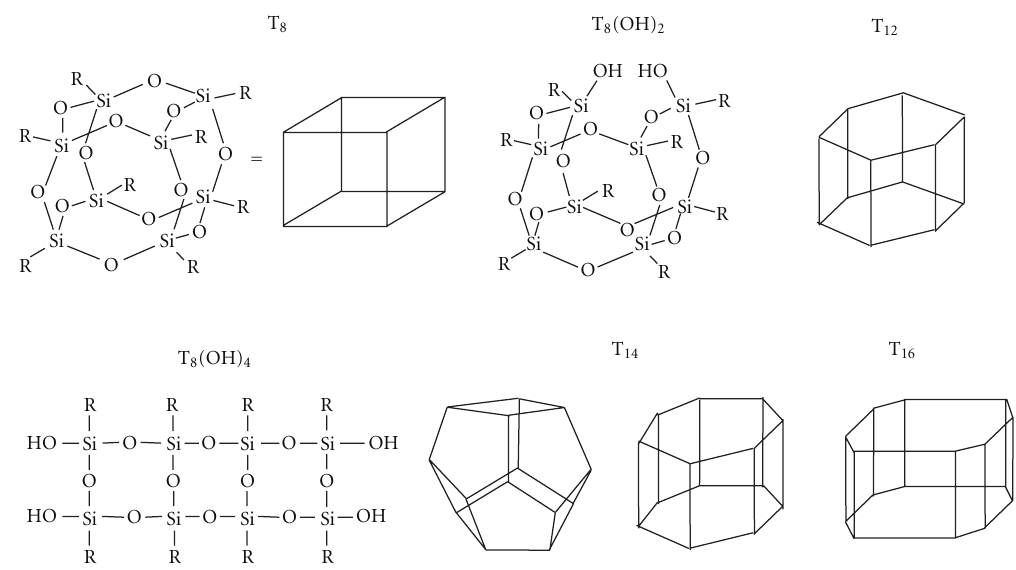
Figure 1: Schematic representation of various structures, ladder (T 8 (OH) 4 ), partially cage (T 8 (OH) 2 ), and cage (T 8 –T 16 ) structures. which is denoted as T n ( n = even number),